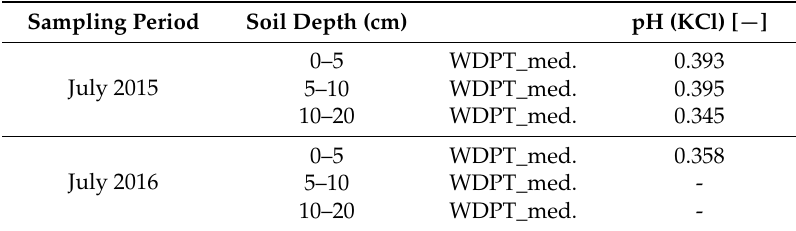
Table 2. Spearman’s rank correlation coefficients between median WDPT test value ( n = 33) and the pH (KCl) of soil at 0–5 cm, 5–10 cm, and 10–20 cm depths in two sampling periods. Only significant coefficients are shown ( p ≤